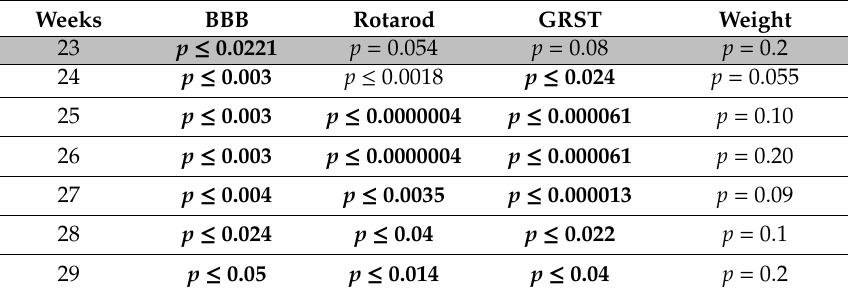
Table A1. Statistical analysis of behavioral tests between asymptomatically NP-iPS-treated group of animals and vehicle-treated littermates.